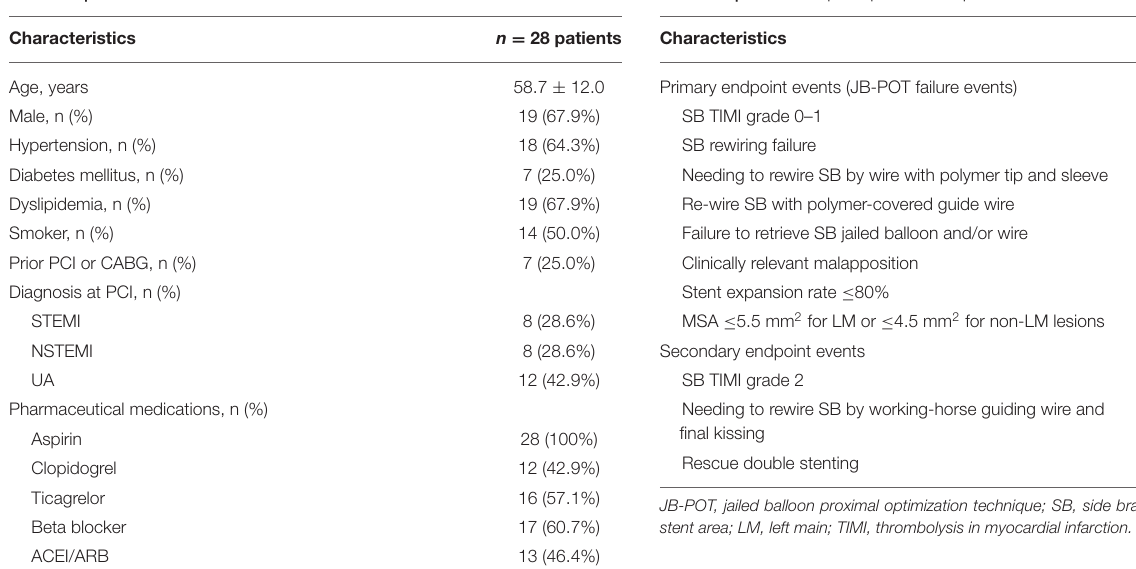
TABLE 3 | Immediate postoperative endpoint events.